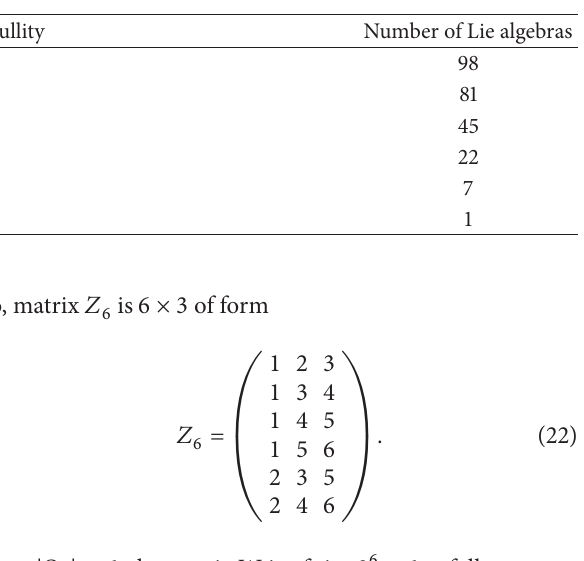
Table 5: Number of 9-dimensional nilsoliton metric Lie algebra